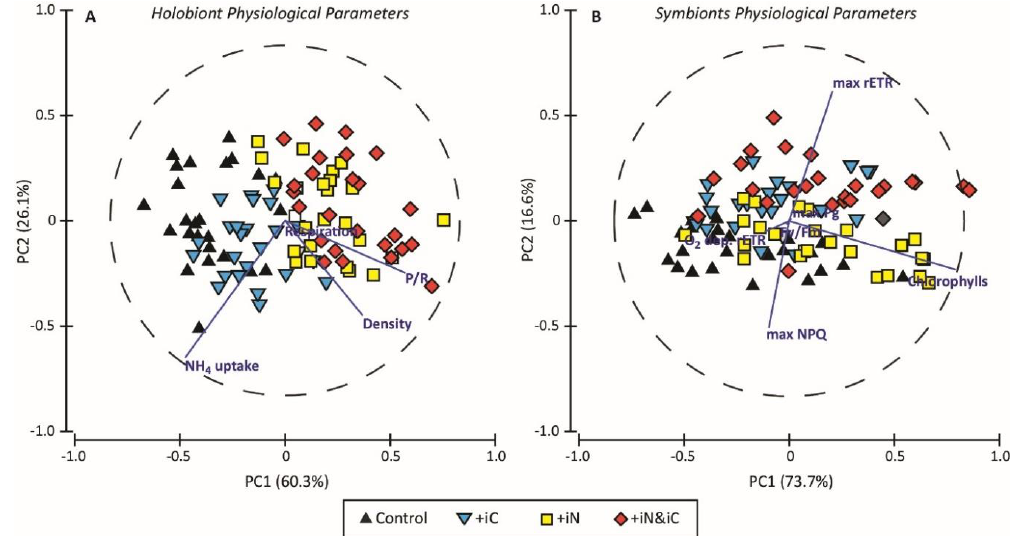
Figure 1. The principal component analyses bi-plots on parameters related to ( A ) the holobiont physiology and to ( B ) the symbiont physiology and photobiology. Black triangles, blue inverted triangles, yellow squares and red diamonds represent, respectively, S. pistillata nubbins exposed for 3 weeks to natural seawater (control) and to seawater enriched with 6 mM HCO 3− (+iC), 4 µM NH 4+ (+iN), both (+iC & iN). Blue lines represent the physiological traits used as descriptors. 3.1. Effects of Increased Ammonium Supply Compared to Control Condition.